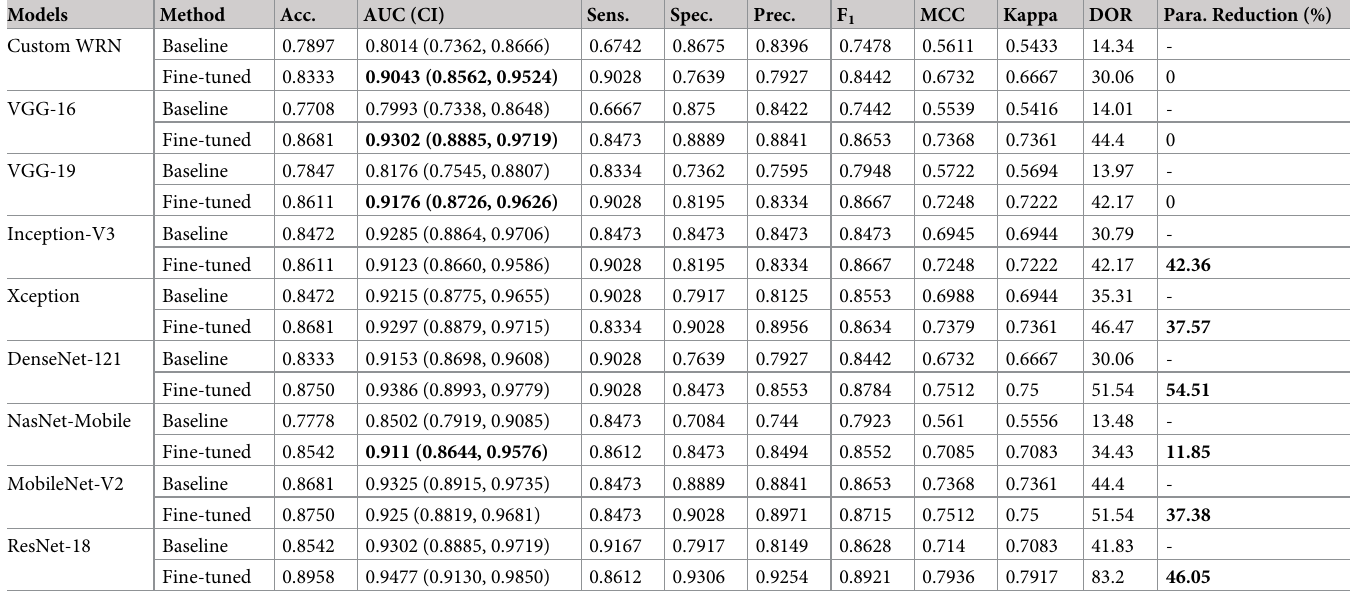
Table 6. Performance metrics achieved during fine-tuning the second-stage pretrained models for COVID-19 detection is compared with the baseline. Models